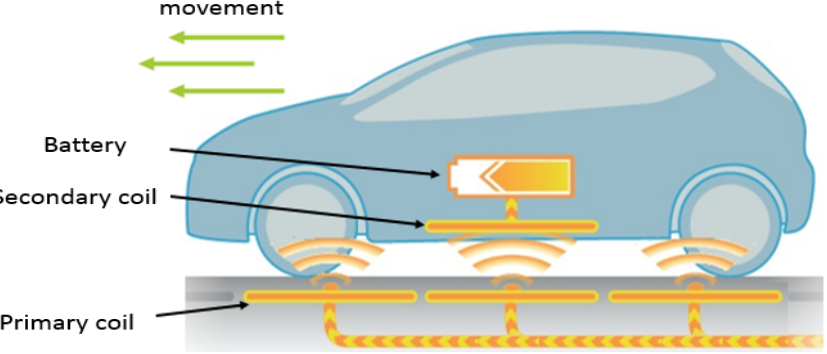
Figure 3. Dynamic induction charging of an electric vehicle [25].